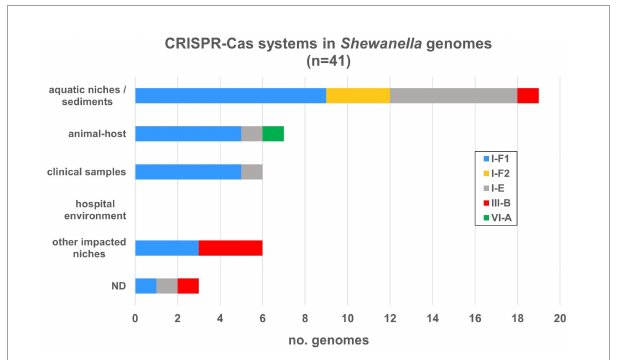
FIGURE5 CRISPR-Cas systems identified in Shewanella spp. genomes from different niches. CRISPR-Cas systems were depicted according to the source of each strain. Colored bars represent each subtype (I-E, I-F1, I-F2, III-B, and VI-A) ( Supplementary Table 12